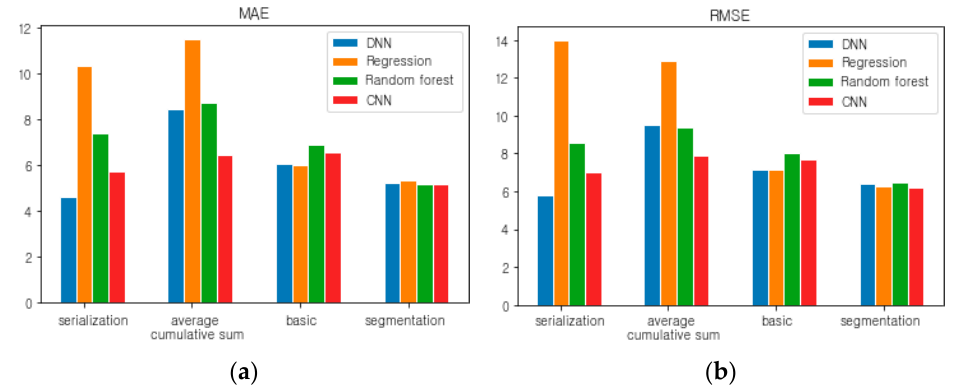
Figure 11. Performance comparison between the four methods with the four learning models ( a ) for the MAE and ( b ) for the RMSE